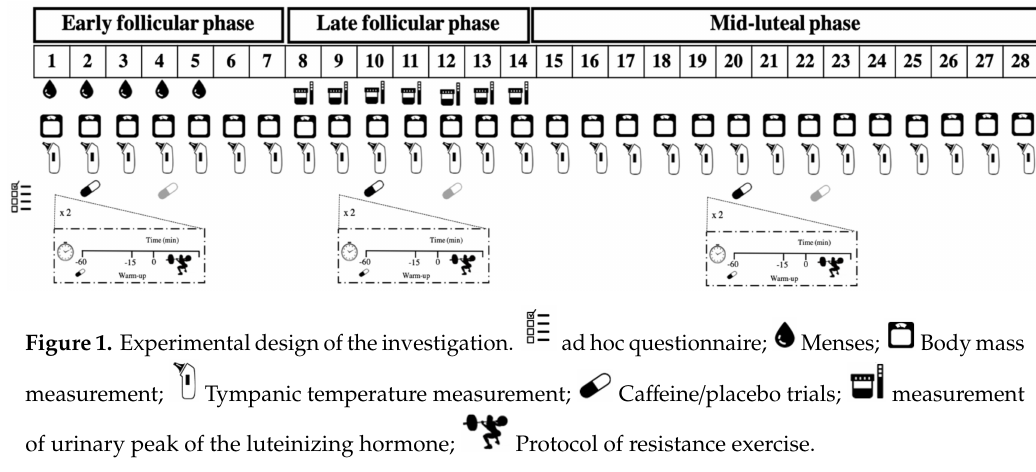
Figure 1. Experimental design of the investigation. ad hoc questionnaire; Menses; Body mass measurement; Tympanic temperature measurement; Ca ff eine / placebo trials; measurement of urinary peak of the luteinizing hormone; Protocol of resistance